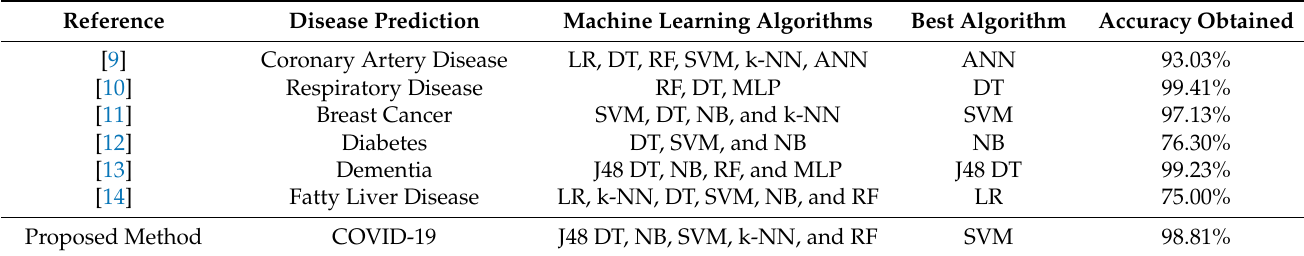
Table 1. Machine learning algorithms used in building a disease prediction model; the best algorithm and the accuracy obtained are